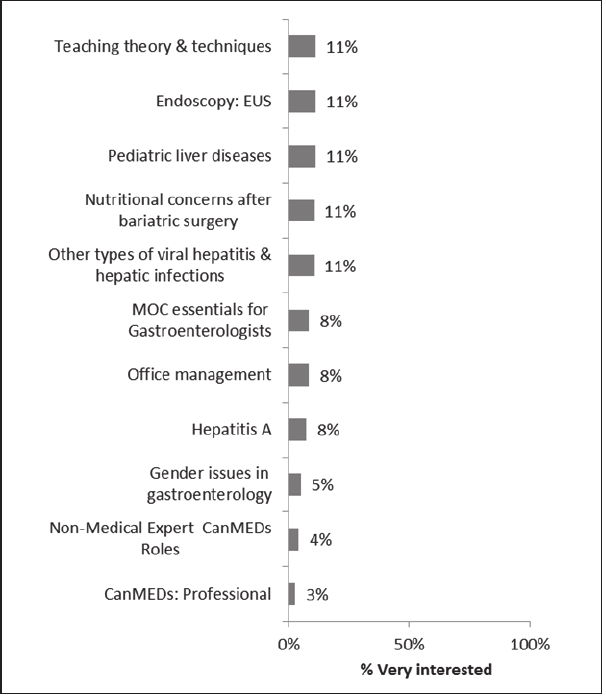
Figure 2) Educational topics in which 16% to 20% of respondents were ‘very interested’. C difficile Clostridium difficile ; Dx Diagnosis; GI Gastrointestinal; NAFLD Non-alcoholic fatty liver disease